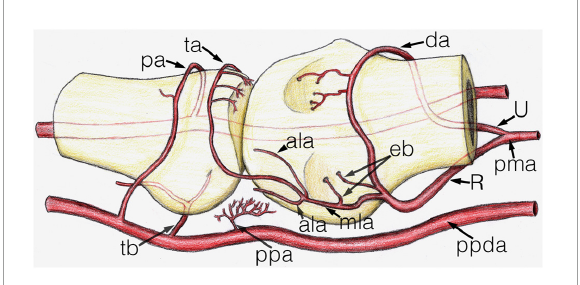
FIGURE5 Schematic drawing of the main arterial vessels of the metacarpophalangeal joint. The proximal (metacarpal) half and distal (phalangeal) half are shown on the right and left side of the image respectively. ala, accessory lateral artery; da, dorsal arcade; eb, enthesial branch; mla, main lateral artery; pa, phalangeal arcade; pma, palmar metacarpal artery; ppa, palmar plate artery; ppda, proper palmar digital artery; R, R-branch; ta, triangular arcade; tb, tenosynovial branch; U,